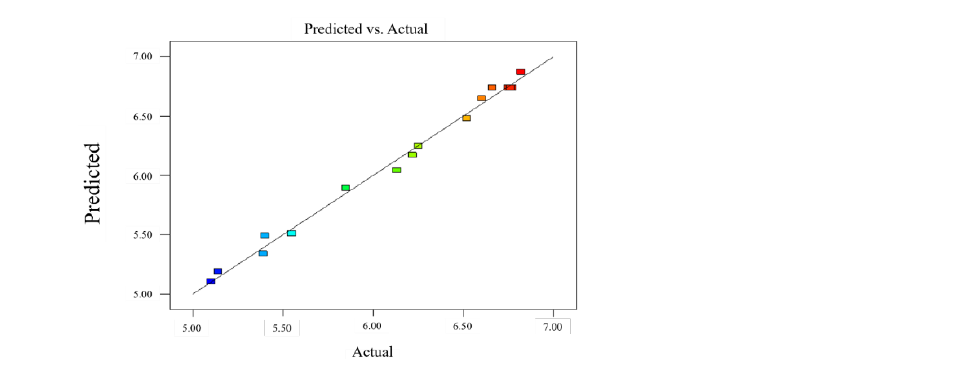
Figure 3. Comparison between the true value and the predicted value in the response surface model. Table 4. Model variance analysis of the influence of vacuum time, heat-sealing time, and cooling time on sealing